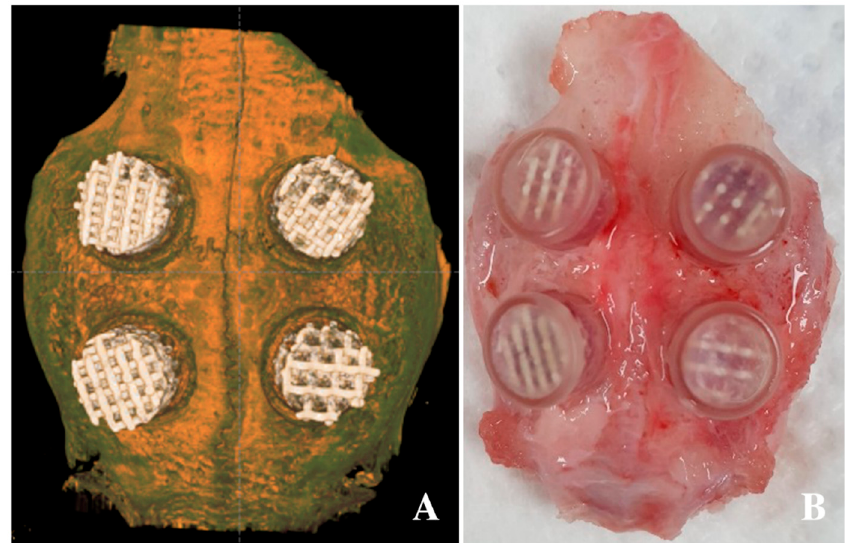
Figure 5. Application of 3D-printed HA/TCP scaffolds in the defect of the calvarium: ( A ) radiographic image after application of the scaffolds and ( B ) clinical photo after scaffold application.